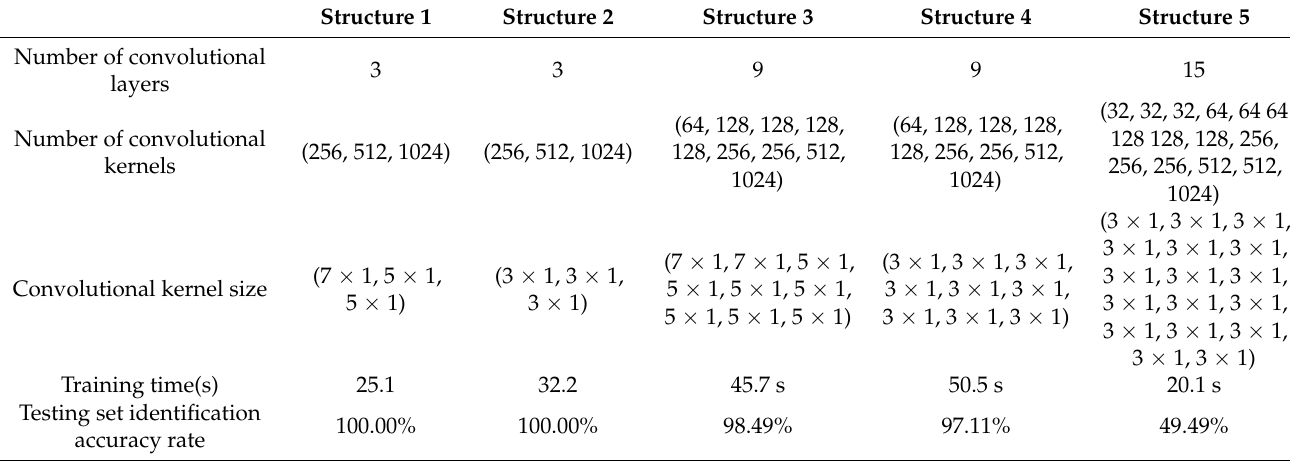
Table 2. Performance comparison of five network